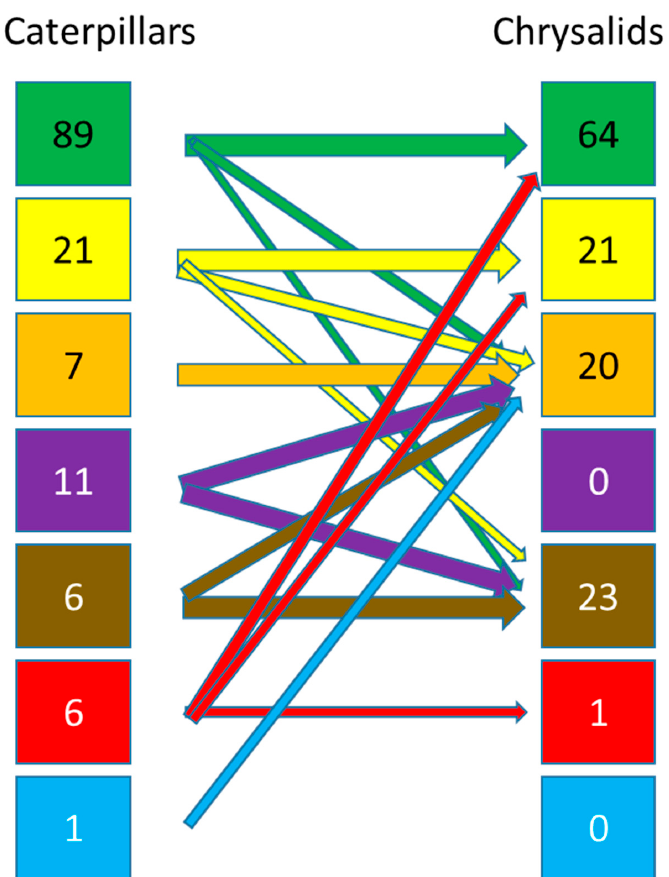
Figure 2. Main changes in environmental or food use between caterpillars and pupae. The width of the arrows is relative to the number of switches. Green: leaf use, yellow: stems or wood, orange: litter, purple: fungi, brown: soil, red: carnivores or pupation in anthills, and blue: fresh water.